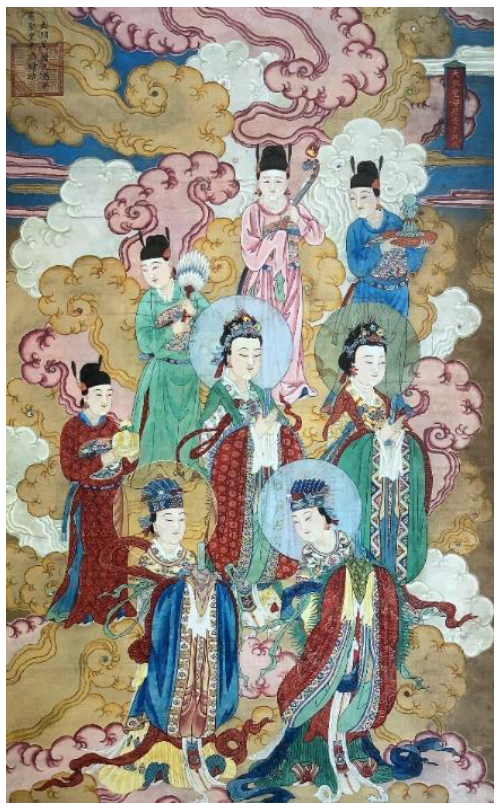
Figure 12. The portrait of the Mother of Heavenly Concubine and Bixiayuanjun. Source: author’s photograph.